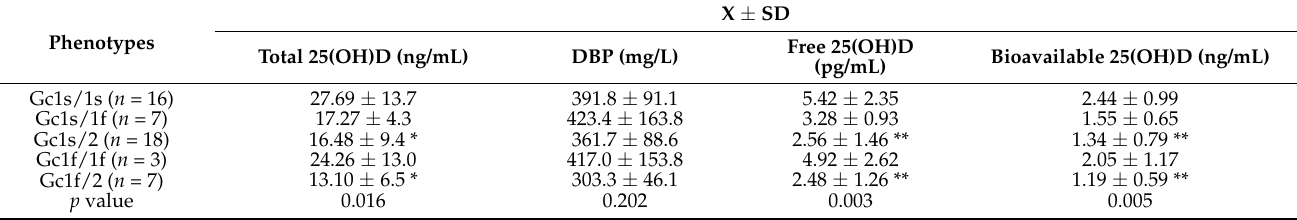
Table 5. Comparison of the phenotypes of GC gene according to biochemical parameters.